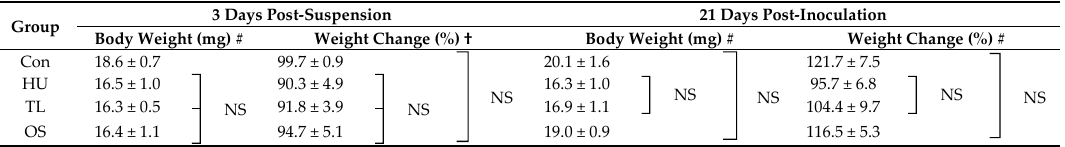
Table 1 . Body weight change in four suspension conditions measured at 3 days after suspension and 21 days after tumor cell inoculation.